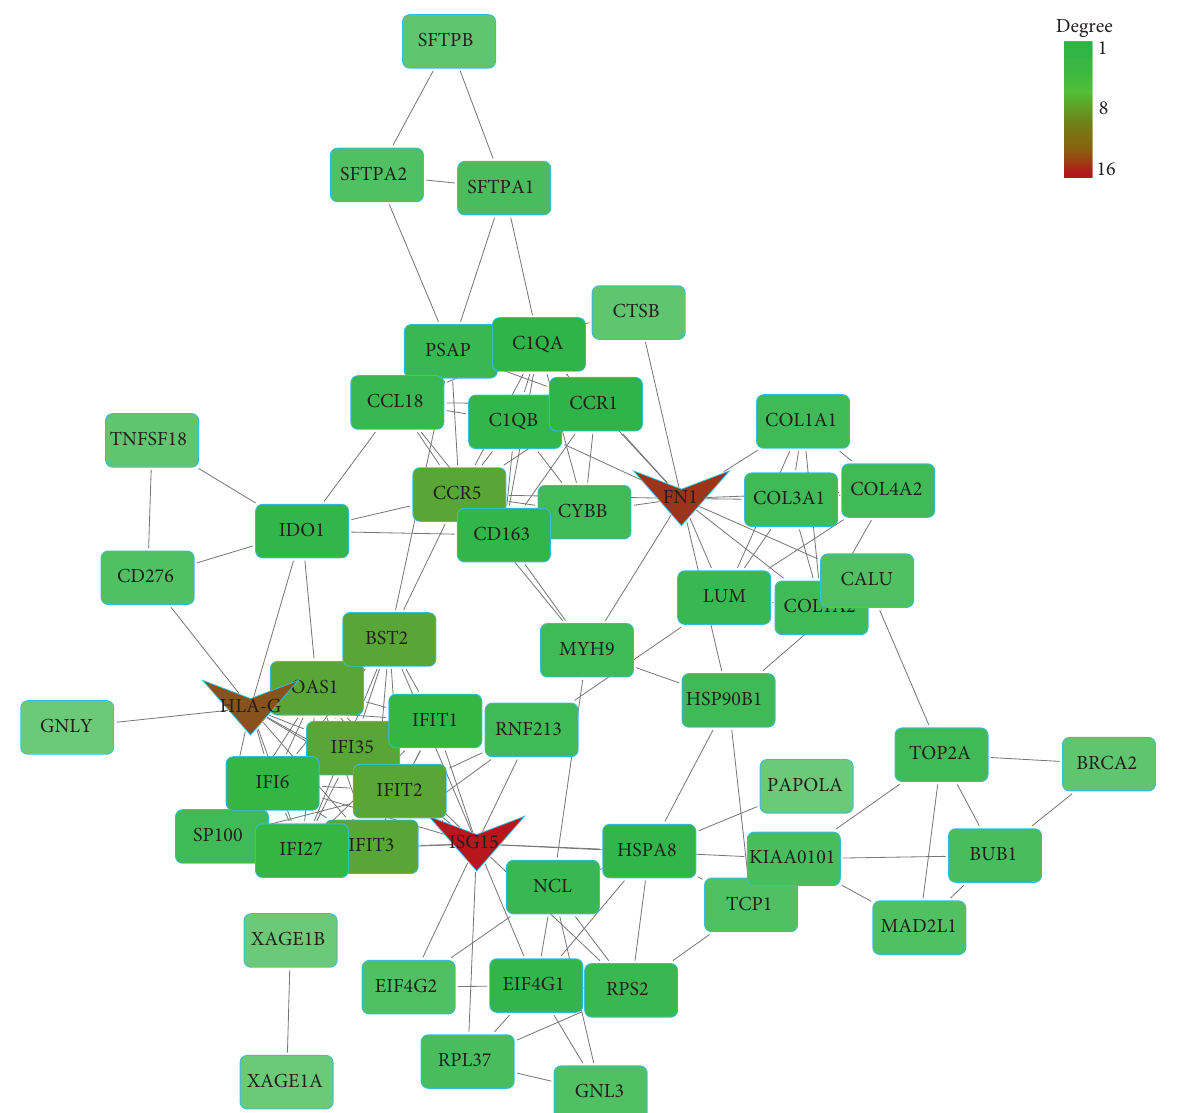
Figure 5: PPI network of upregulated DEGs. The PPI network consists of 53 nodes and 158 edges. Nodes represent genes, and edges represent interactions between genes. The darker-colored nodes represent the hub genes, which are ISG15, FN1, and